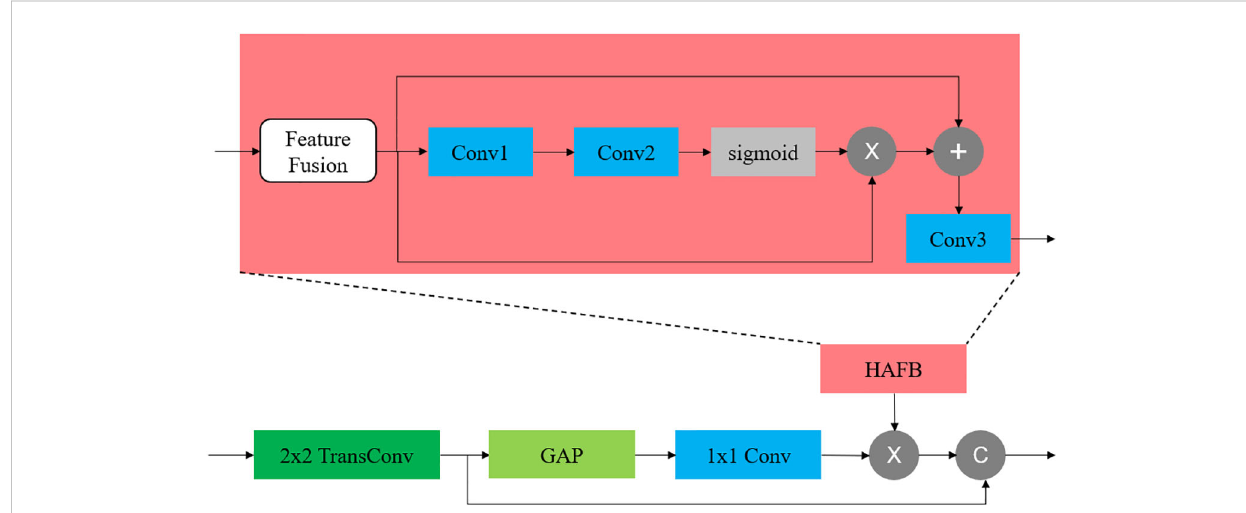
FIGURE 2 The location of HAFB in the network and its internal structure. The HAFB structure is introduced into the skip connection part. The feature fusion adopts the hybrid fusion